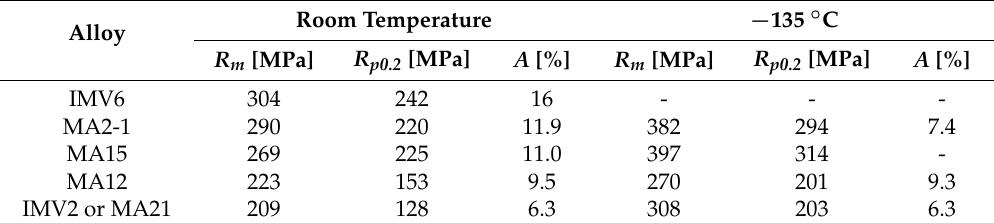
Table 10. Fatigue life N 0 and length of fatigue micro-crack initiation N i at room temperature and − 135 °C [28].